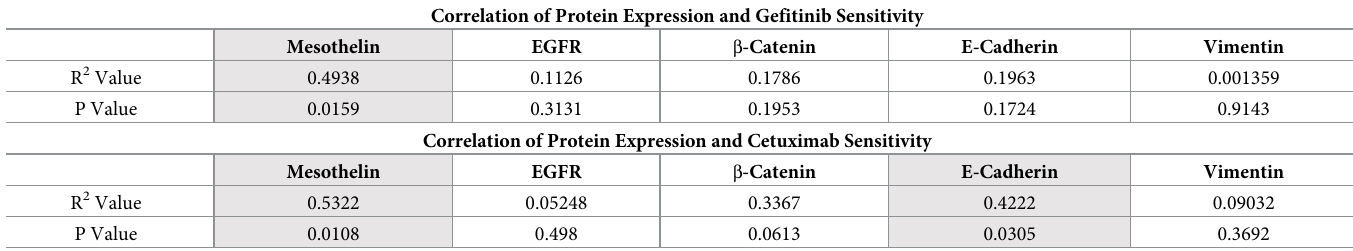
Table 2. Correlations between protein expression and EGFR inhibitors sensitivity. Correlation of Protein Expression and Gefitinib